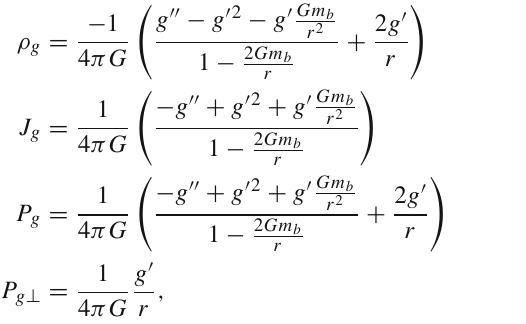
provided that the compatibility condition on J be